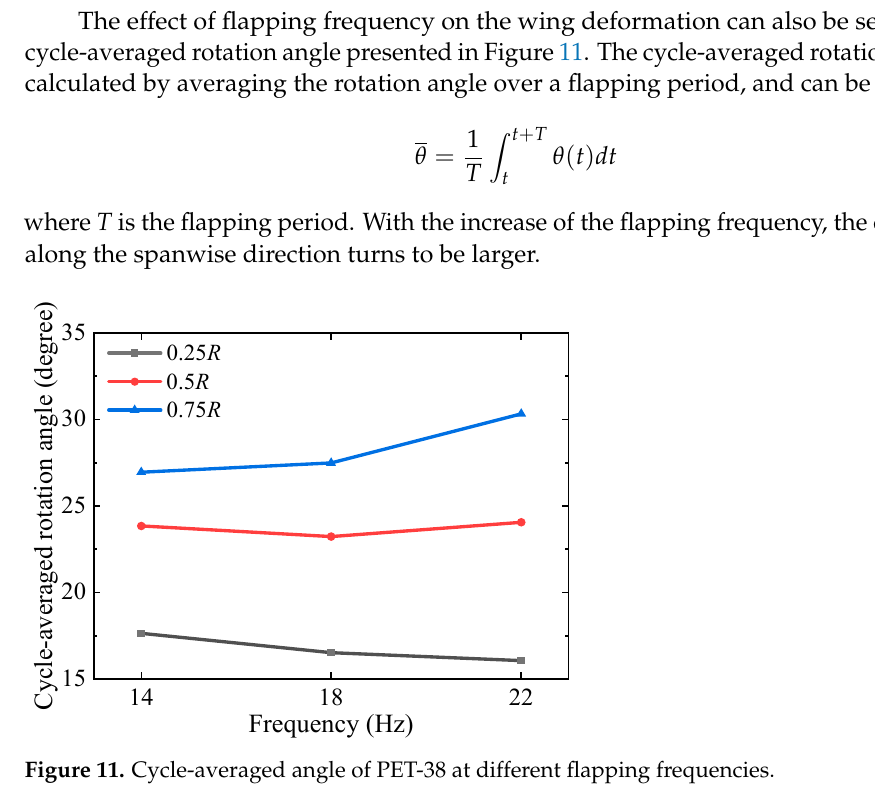
Figure 11. Cycle-averaged angle of PET-38 at different flapping frequencies.